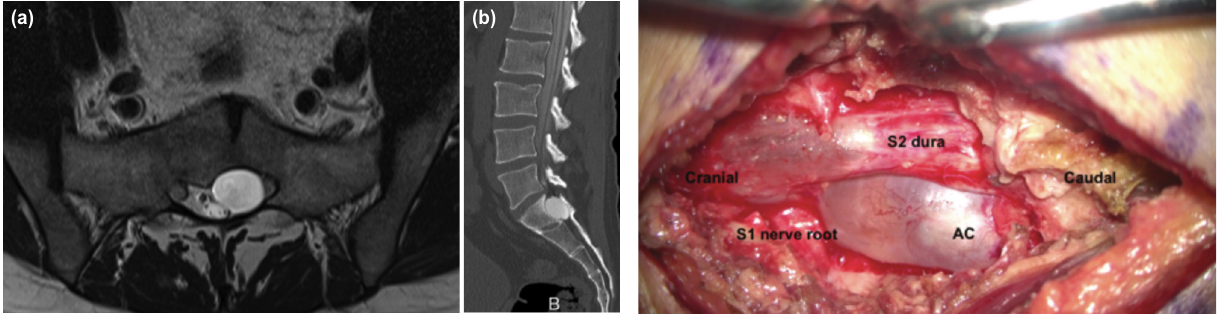
Intra-operative image of arachnoid cyst (AC) Fig. 2: encapsulating the S1 nerve root.